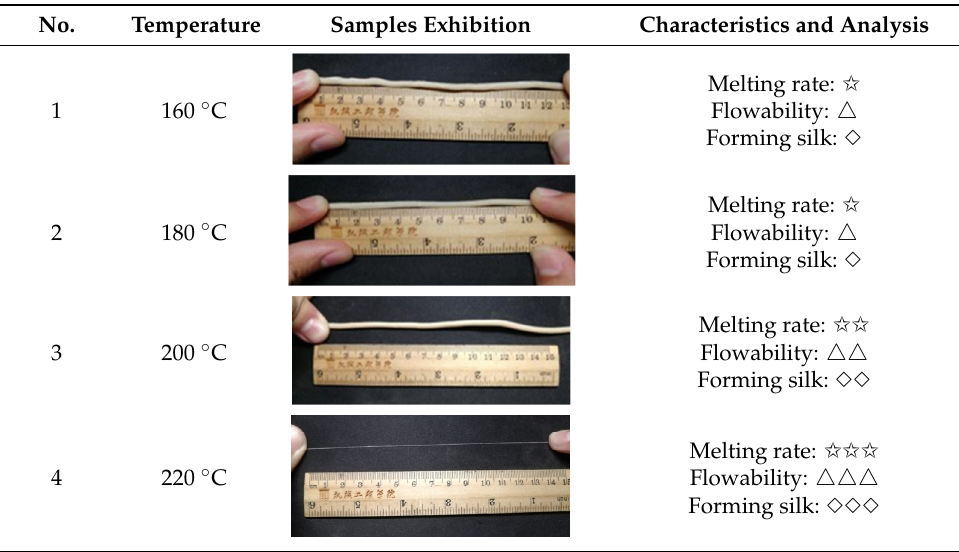
Table 4. Performance effects of different melting temperatures on ceramic fiber at feed speed of screw of 15 mm/min, TPU ‐ 95A# and nozzle diameter depending on the situation.